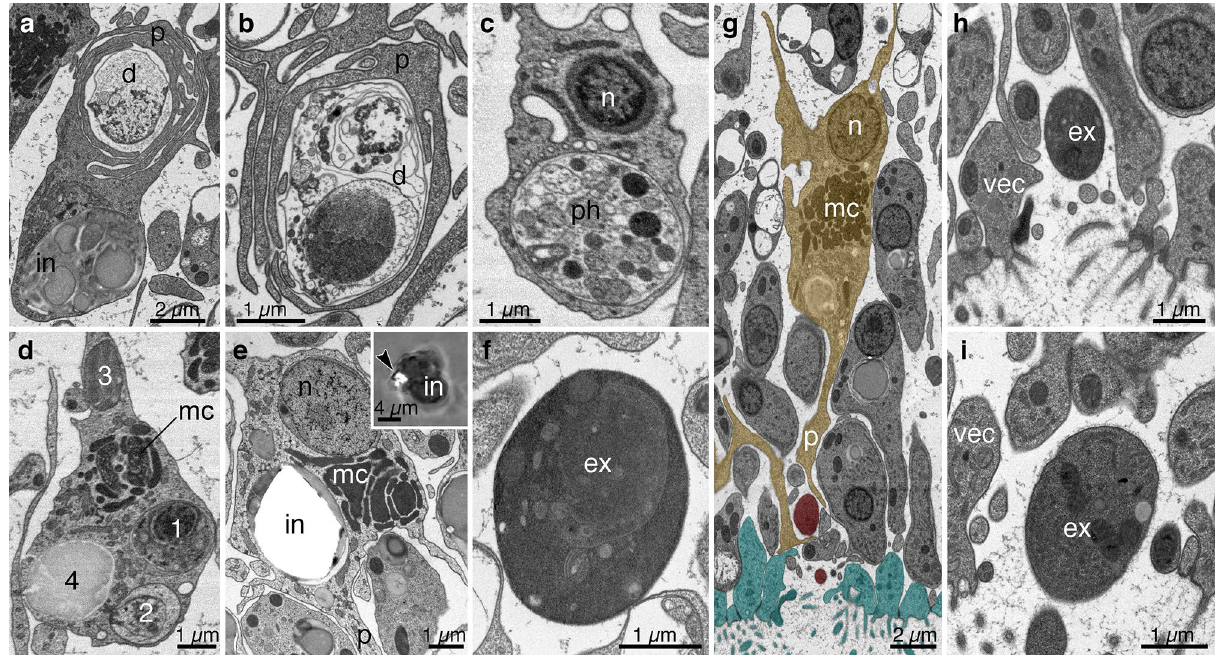
Figure 3. Fiber cell involvement in phagocytosis of unhealthy/dead cells. ( a ) A fiber cell containing a characteristic inclusion (in) encircles cell debris (d) with multiple branching processes (p). ( b ) Fiber cell processes wrapped around a dead cell (d) containing nuclear and vesicular remnants. ( c ) Phagosome (ph) with heterogeneous and vesicular content, likely representing recently phagocytosed cell debris. ( d ) A fiber cell with four phagosomes (1–4) exhibiting different degrees of processing/digestion: phagosomes 1 and 2 still have remnants of cell organelles, while phagosomes 3 and 4 are more homogeneous and may represent later stages of processing. ( e ) A fiber cell with an empty space in its inclusion corresponding in shape and size to a crystal in a crystal cell; inset shows a differential interference contrast (DIC) image of a living fiber cell with a crystal (arrowhead) inside it, perhaps representing a phagocytosed crystal cell. ( f – i ) Extracellular residual bodies. ( f ) An extracellular dark particle (ex) in the interior of the animal. The content of the particle is electron dense and relatively homogeneous, similar to phagosomes observed in the interior of fiber cells ( d , phagosome 3). ( g ) Fiber cell processes (mustard) associated with extracellular dark particles (red) located near gaps between cells in the ventral epithelium (cyan). ( h ) The extracellular dark particle near the mouth of the gap in a different section from the series shown in g. ( i ) A dark particle located outside of another animal near a breach in the ventral epithelium. ( a , b , e – i )—TEM; ( c , d )—SEM in backscatter mode. mc mitochondrial complex, n fiber cell